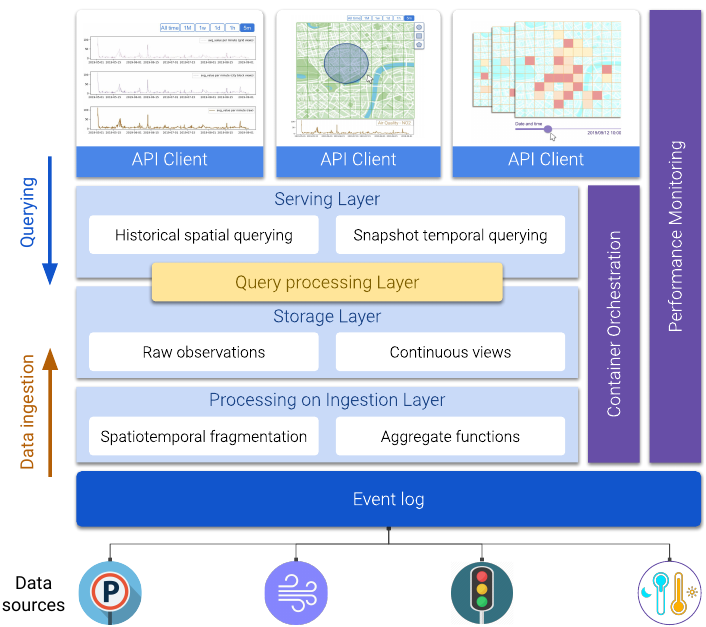
Figure 6. Components and architecture of the E XPLORA